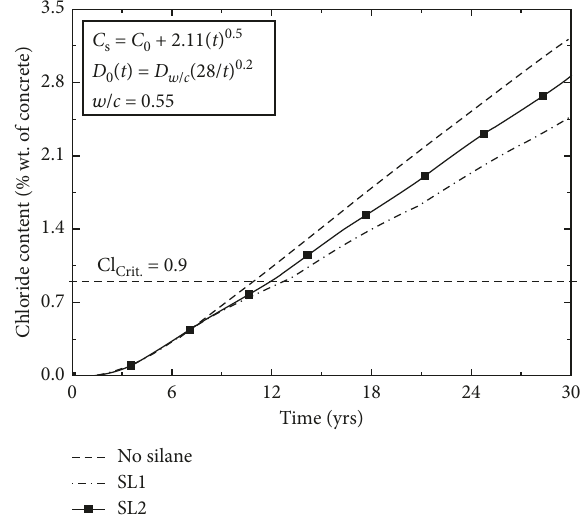
Figure 7: Chloride content versus time for concrete without and with SL1 and